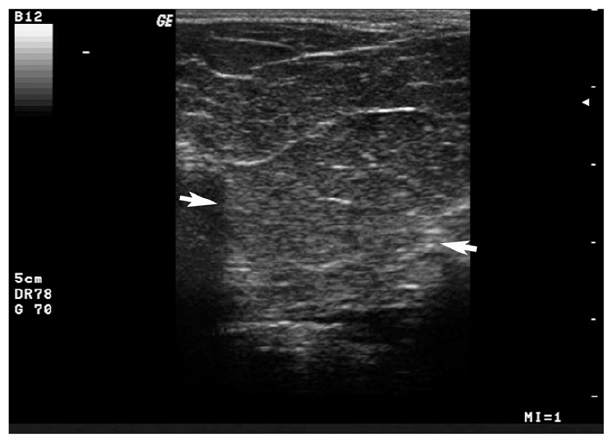
Figure 3. Ultrasound image of perineal lipoma. An infiltrative perineal lipoma, ultrasonographically appearing hypoechoic and multi- lobulated because of thin hyperechoic lines; a thin limiting capsule is visible (arrows).